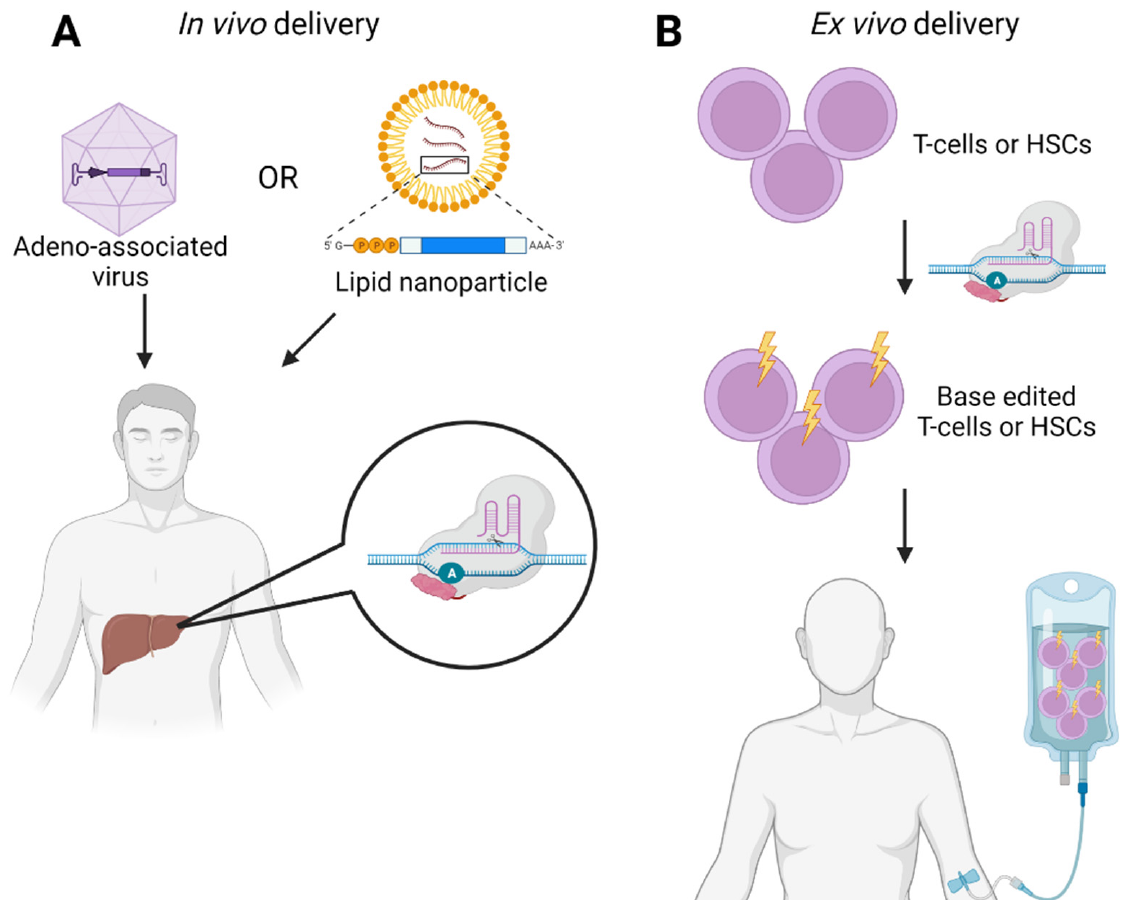
Figure 4. Delivery systems for base editors. ( A ) Base editors can be delivered directly to patients in vivo, typically through adeno-associated viruses or lipid nanoparticles. The base editor then acts directly in patients (e.g., VERVE-101 edits PCSK9 in the liver). ( B ) Base editors can also be used to modify T cells or HSCs ex vivo before the edited cells are infused into patients.